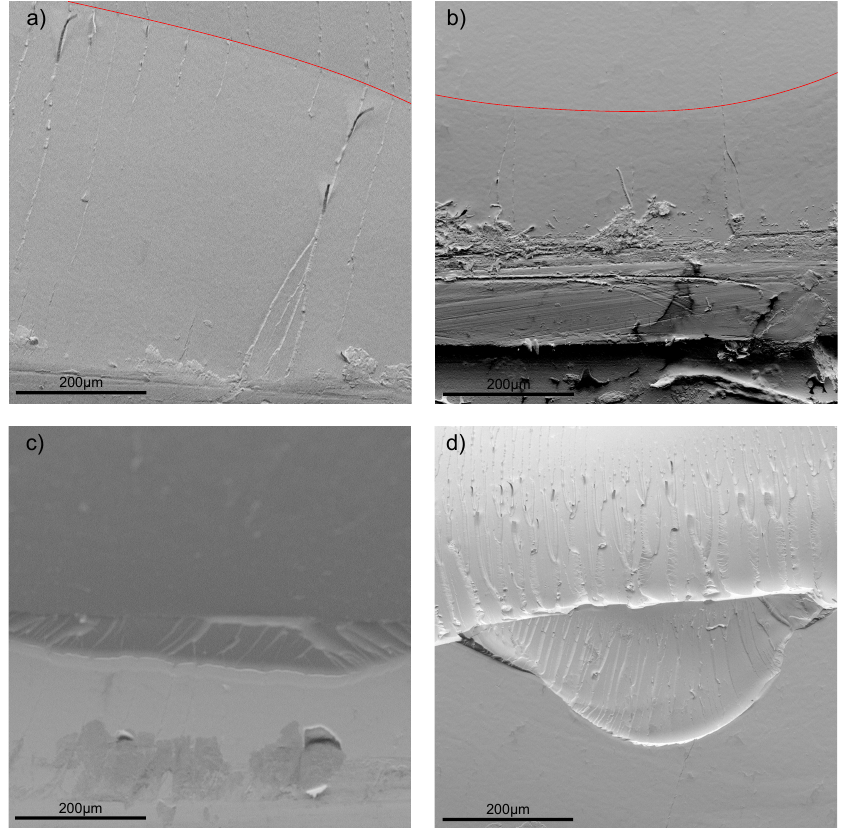
Figure 17. SEM images of the fracture surfaces of 0.1wt.% SWCNT in Epikote 828LVEL ( a ) Tuball purified mode I ( b ) Tuball 75 mode II ( c ) Tuball purified mode II ( d ) Tuball 75 mode